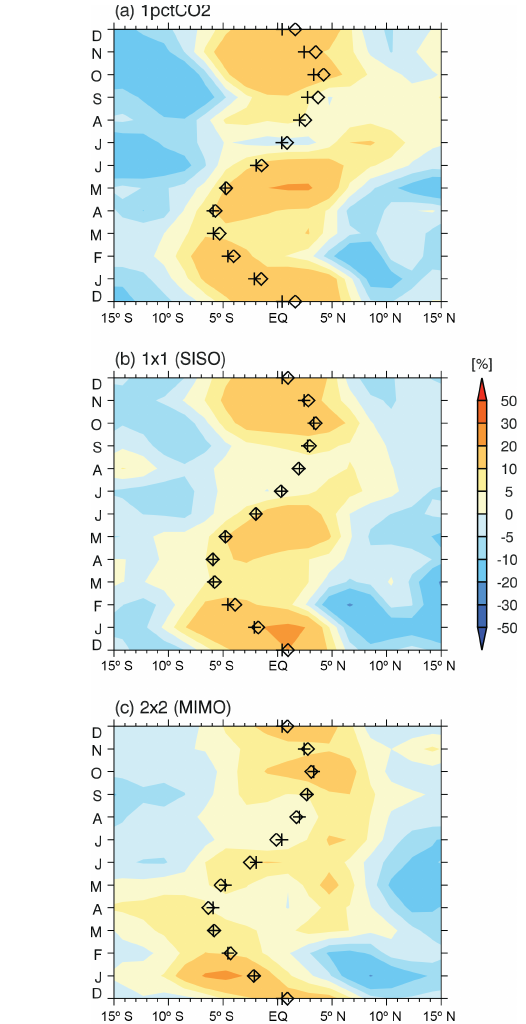
Figure 14. Climatology of percent change (with respect to piCon- trol) in total precipitation (shading; %) and shift in the precipitation centroid ( χ , Eq. 1); symbols) for the 2 × 2 case in the design model. The top panel corresponds to 1pctCO2, the middle panel corre- sponds to the Arctic Only simulation, and the bottom panel cor- responds to the full 2 × 2 simulation. Plus signs indicate piControl, and diamonds indicate the perturbed simulation. All values are aver- aged over years 59–68 of simulation and are linearly bias-corrected to account for small differences in background conditions between the perturbed simulations and piControl.